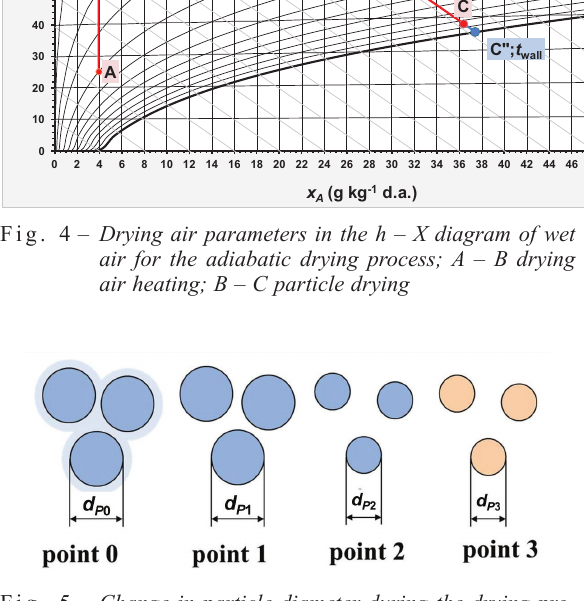
Fig. 5 – Change in particle diameter during the drying pro- cess Fig. 5 - Change in particle diameter during the drying process Pavel Hoffman: Effect of fluidized bed stirring on drying process of adhesive particles